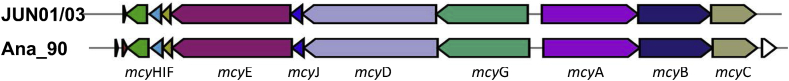
The 55-kbp mcy gene cluster derived from JUN01 and JUN03 metagenomes has the same gene arrangement as the mcy cluster from Anabaena sp. 90. Overall nucleotide identity = 98.8%.